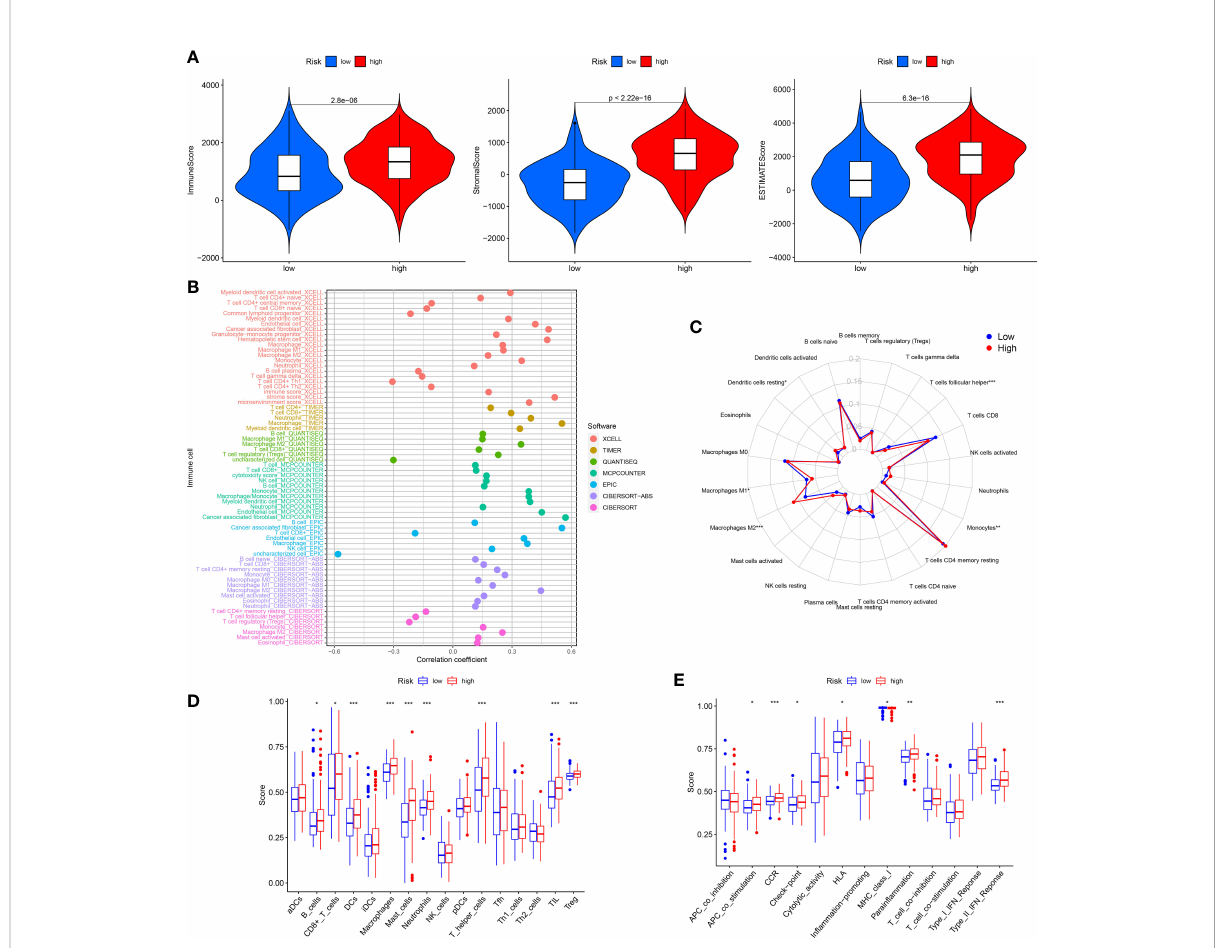
FIGURE 6 Analysis of immune conditions of high and low risk groups. (A) Differences of immune microenvironment scores between the two groups. (B) The analysis of differences in immune cell in fi ltration between the two groups with Multiple algorithms. (C) The analysis of differences in immune cell in fi ltration between the two groups with the CIBERSORT algorithm. (D) The analysis of differences in immune cell in fi ltration between the two groups with ssGSEA. (E) The differences of immune functions between the two groups with ssGSEA. *P < 0.05; **P < 0.01; ***P <